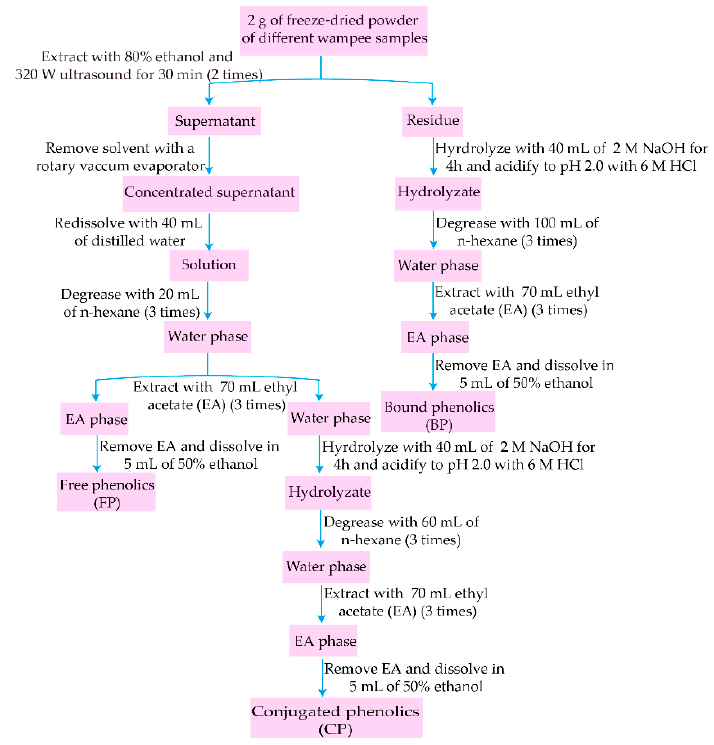
Figure 1. Extraction procedures of free, conjugated, and bound phenolic fractions.